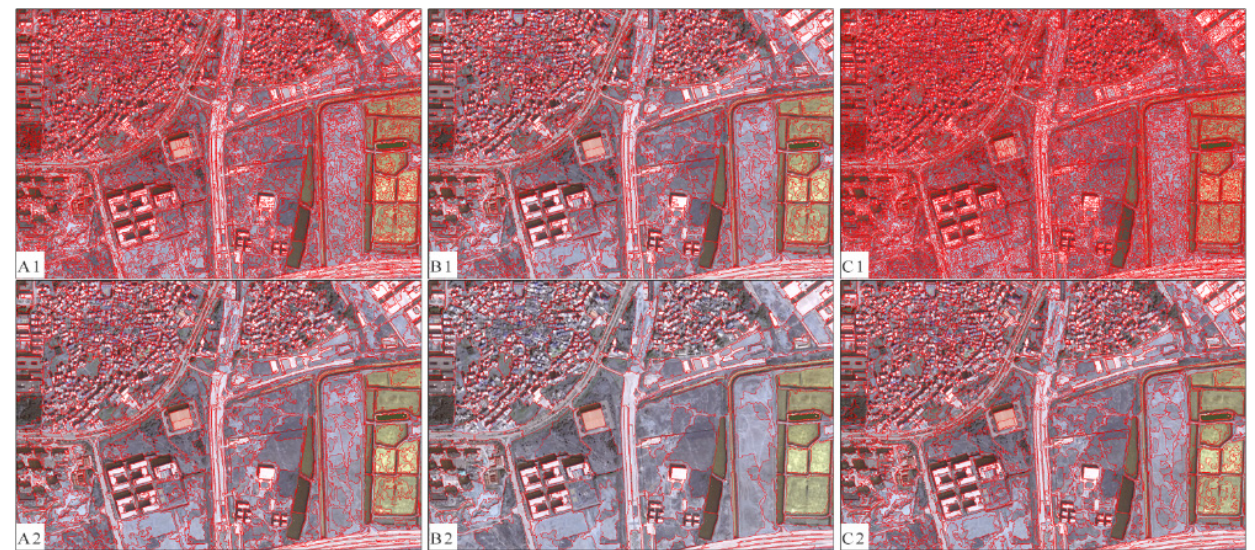
Figure 11. Comparison of SRM module segmentation effect. ( A1 , A2 ) The segmentation results before and after SNIC, respectively; ( B1 , B2 ) The segmentation results before and after SLIC, respectively, and ( C1 , C2 ) are the segmentation results before and after